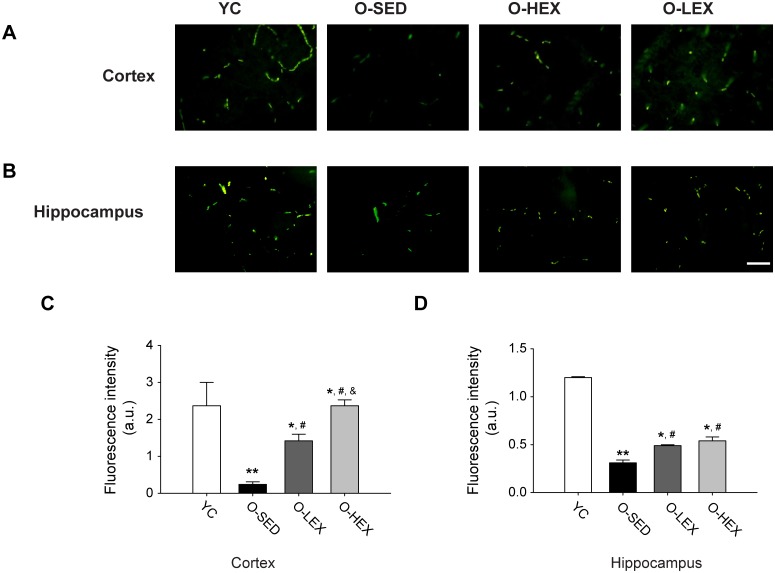
Exercise reverses the synapse loss during aging.(A-B) Representative positive immunofluorescence staining of synaptophysin in the cortex (A) and hippocampus (B) in four groups. (C-D) Summary of the mean fluorescence density in the cortex (C) and hippocampus (D) in four groups. Values are mean and standard error of the mean, n = 5 in each group. ** P< 0.01 vs. YC, #P< 0.05 vs. O-SED, & P< 0.05 vs. O-LEX. Bar = 100 μm.